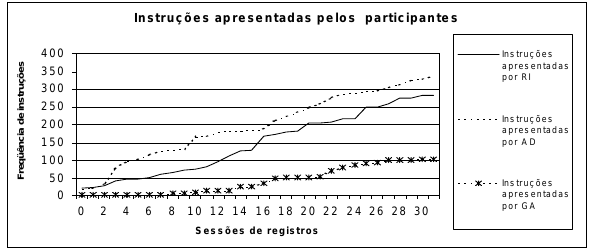
Figura 1 . Freqüência de instruções apresentadas pelas crianças partici- pantes no período de Levantamento de Repertório de Entrada (sessão 0) e ao longo das 31 sessões de coleta de